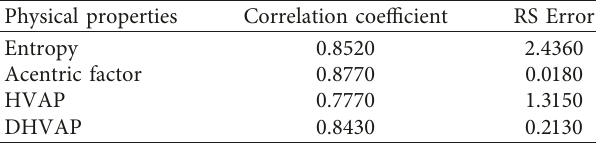
Table 3: HGI and parameters of regression models.